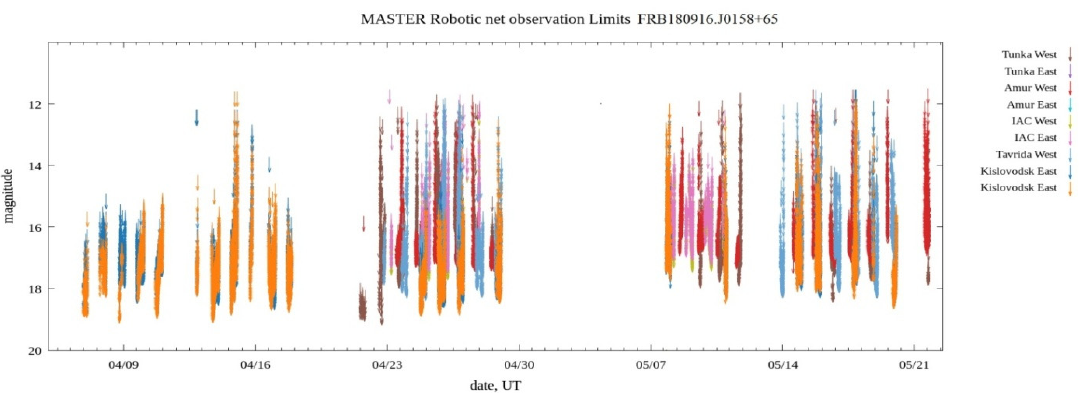
Figure 6. MASTER optical monitoring limit for FRB 180916.J0158+65 obtained at the 5 telescopes located in the northern hemisphere which covered 3 periods of activity and partly, the quiescent periods between them.